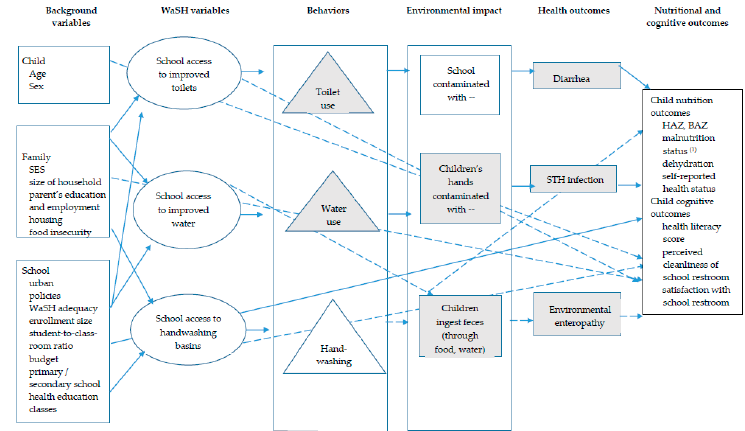
Figure 1. Conceptual framework for water, sanitation, and hygiene (WaSH) and child nutrition, hydration, and cognitive outcomes. Adapted from Dearden et al. [26]. Note: body mass index-for-age z-score (BAZ), height-for-age z-score (HAZ), socioeconomic status (SES); soil-transmitted helminth (STH), water, sanitation, and hygiene (WaSH). We will analyze relationships symbolized by solid arrows, not dashed arrows. Variables that may not be available for analysis during this phase of the research project are symbolized by gray color. (1) Malnutrition status: stunted, undernourished, and over-nourished.